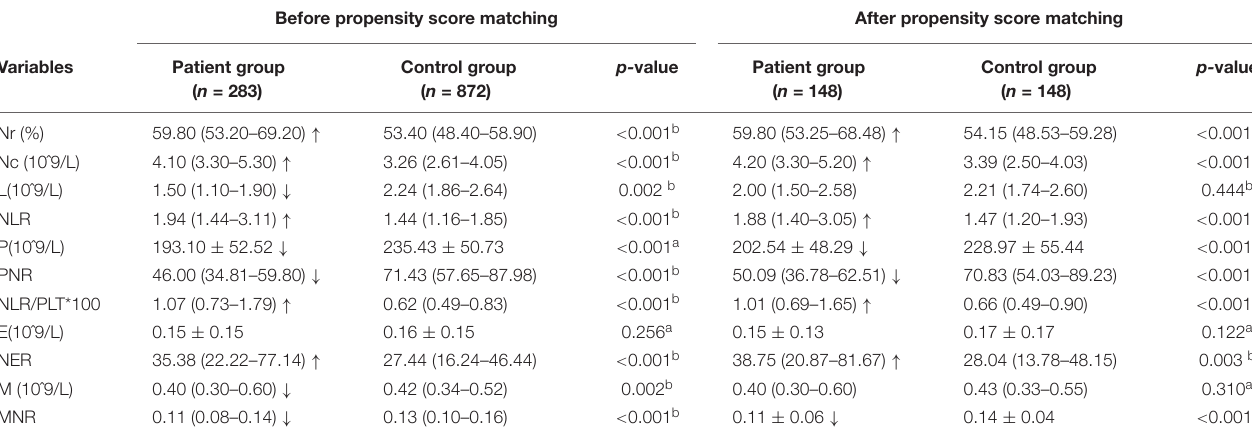
TABLE 1 | Demographic and laboratory characteristics of the AIS patients and healthy controls before and after matching (1:1 match, caliper 0.1). Before propensity score matching After propensity score